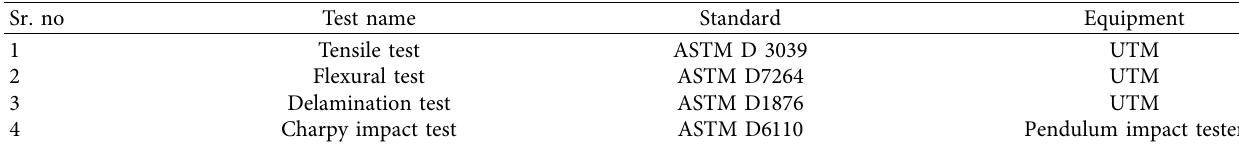
Table 2: Test types and standards used for